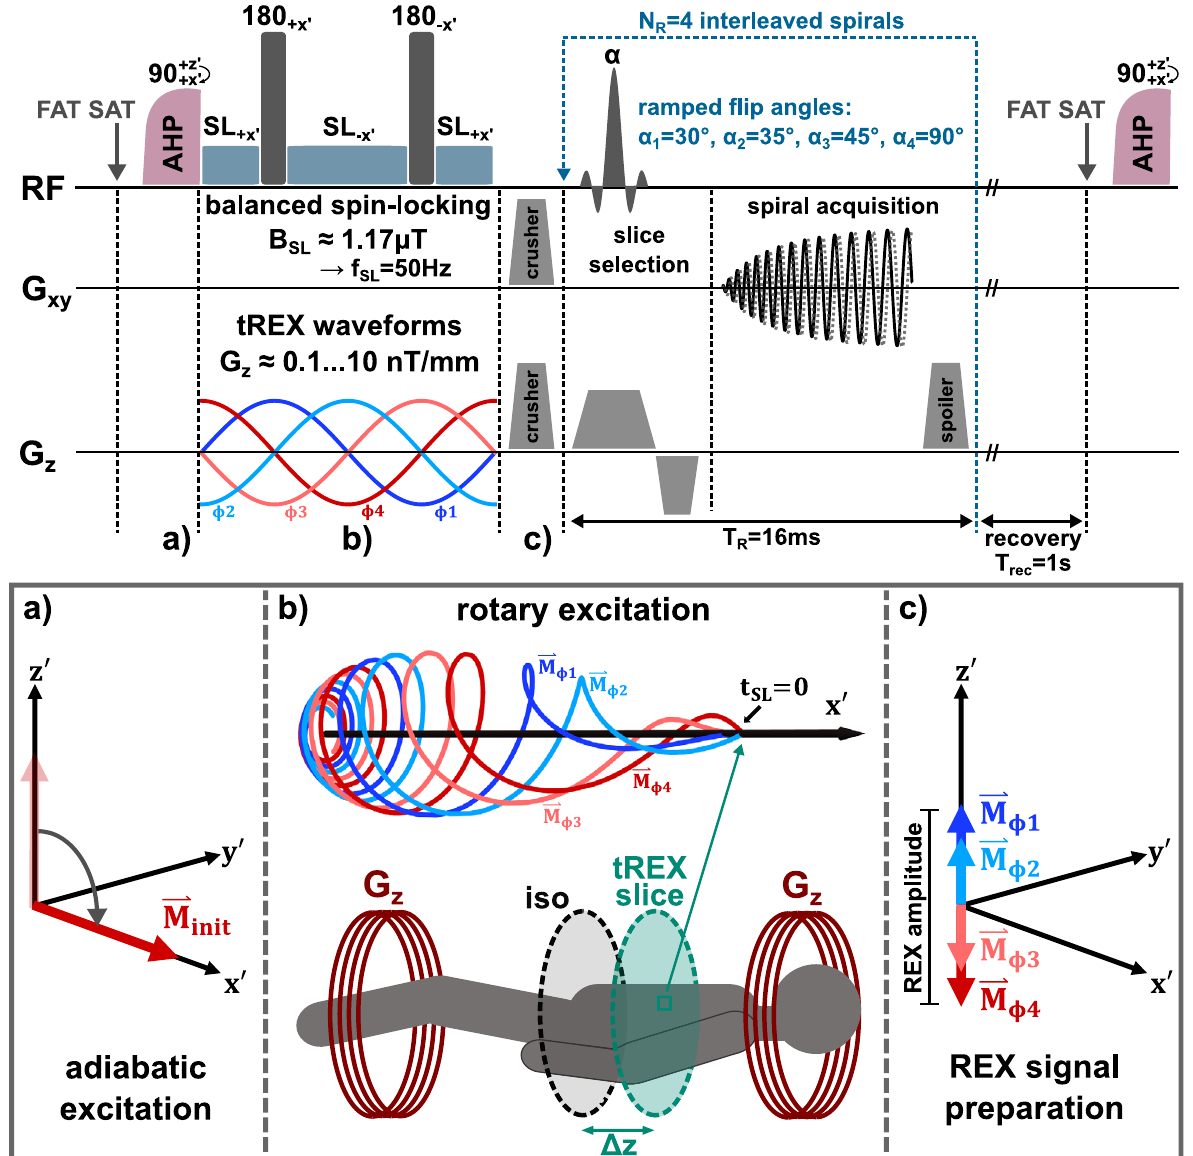
Figure 1. Sequence concept for validation of ultra-weak magnetic field detection using tREX for phantom or in vivo experiments (RF = radio-frequency event, G x , G y , G z = gradient field event). The upper part of the figure shows the pulse sequence using the B-SL preparation module. In the in vivo experiments, the k-space acquisition was performed with ramped flip angles and four interleaved spirals were used for a fast readout of the REX weighted contrast. In the phantom experiments, the spiral readouts were replaced by TSE readouts. Subfigures ( a – c) explain the individual steps of magnetization behavior. After fat saturation, an adiabatic excitation pulse flips the magnetization to the transverse plane as shown in ( a ). This is followed by one of the four spin-lock preparation modules (B-SL is illustrated exemplarily). During SL preparation, the interaction with the ultra-weak magnetic field oscillation takes place. In the tREX approach the oscillating field is generated by sinusoidal waveforms of the built-in gradient system. To obtain a non-zero amplitude, the measurement must be performed in an offcenter slice, as shown in ( b ). The excitation process of the magnetization perpendicular to the spin-lock axis is dependent on the relative phase between spin-lock pulse and tREX waveform. At the beginning of the spin-lock pulse (t SL = 0) the magnetization is aligned along the x ′ -axis. The perpendicular component increases due to rotary excitation effect and decays simultaneously with the relaxation time constants T 1ρ and T 2ρ . After the preparation module, remaining transverse magnetization is crushed. The resulting longitudinal magnetization in ( c ) depends on the relative phase according to the trajectories shown in ( b